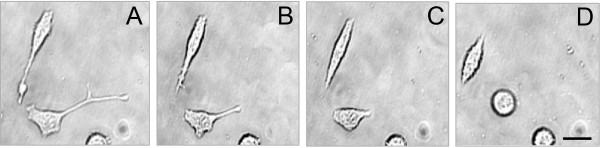
Contrast microscope image of cells treated with amyloid-like tau. The same SH-SY5Y cells were imaged after incubated with tau deposits (2 μM) for 0, 24, 48 or 72 h (A-D). Cells were visualized by inverted contrast microscopy. Bar = 25 μm.